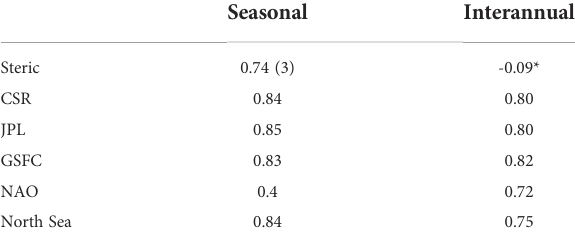
TABLE 2 The correlation coef fi cients between total sea level in the Baltic Sea and the data indicated on the fi rst column.